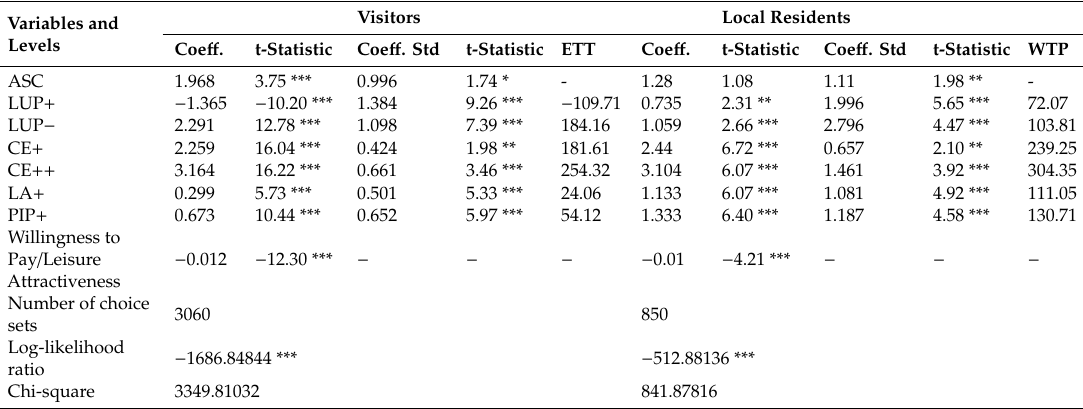
Table 4. Results of random parameter logit